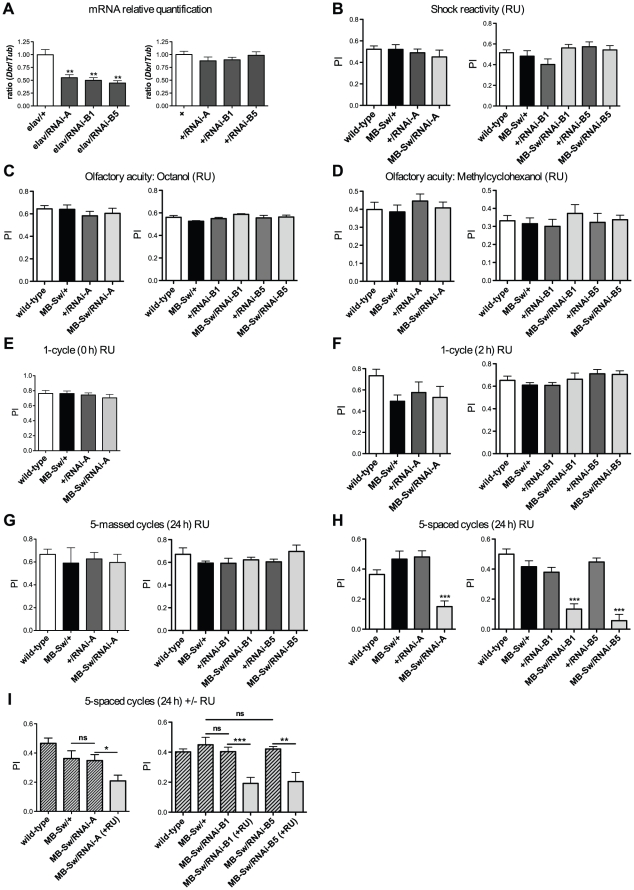

dbr RNAi expression in the adult MBs impairs LTM formation.(A) dbr mRNA expression analyses. Total RNA was extracted from fly heads, submitted to DNase treatment, and further reverse transcribed with oligo(dT) primers. Resulting cDNA was quantified by PCR using tubulin (Tub) expression as a reference. Results are shown as ratios relative to the values observed for elav/+ (left panel, t test, p<0.01, n≥5) and wild-type (+, right panel, t test, p>0.05, n≥4) control flies. (B–I) Behavioral analyses. To silence dbr expression in the adult MBs, flies were fed with RU for 48 hrs prior to conditioning and in (G–I), also for 24 hrs before testing. (B) Shock reactivity (ANOVA, left panel, p = 0.604, n = 9; right panel, p = 0.1049, n≥8). (C) Olfactory acuity for octanol (ANOVA, left panel, p = 0.8099, n = 10; right panel, p = 0.0891, n≥8). (D) Olfactory acuity for methylcyclohexanol (ANOVA, left panel p = 0.9488, n≥8; right panel, p = 0.1633, n≥8). (E) Learning analysis after a single conditioning cycle (ANOVA, p = 0.5396, n = 8). (F) STM analysis 2 hrs after a single conditioning cycle (ANOVA, left panel, p = 0.6264, n≥10; right panel, p = 0.0472, n≥8, the Newman-Keuls post-test is only significant for the MB-Sw/RNAi-B1 vs MB-Sw/+ pair, q = 4.474). (G) ARM analysis 24 hrs after five massed conditioning cycles (ANOVA, left panel, p = 0.5088, n = 16; right panel, p = 0.7635, n≥13). (H) LTM analysis 24 hrs after five spaced conditioning cycles (ANOVA, left panel, p<0.0001, n≥21; right panel, p<0.0001, n≥14). (I) In the absence of RU, LTM is not affected. Flies were either raised on regular medium (hatched bars) or fed with RU for 48 hrs prior to training, and until testing (+RU) (gray bars). Scores were measured 24 hrs after a five-spaced cycle conditioning (t test: left panel, MB-Sw/RNAi-A vs MB-Sw/+, p = 0.8335, MB-Sw/RNAi-A vs MB-Sw/RNAi-A (+RU), p = 0.0222, n = 12; right panel, MB-Sw/RNAi-B1 vs MB-Sw/+, p = 0.4432, MB-Sw/RNAi-B1 vs MB-Sw/RNAi-B1 (+RU), p = 0.0005, n≥8 ; MB-Sw/RNAi-B5 vs MB-Sw/+, p = 0.5989, MB-Sw/RNAi-B5 vs MB-Sw/RNAi-B5 (+RU), p = 0.0015, n≥8). Bars indicate Mean ± SEM, ns, not significant.